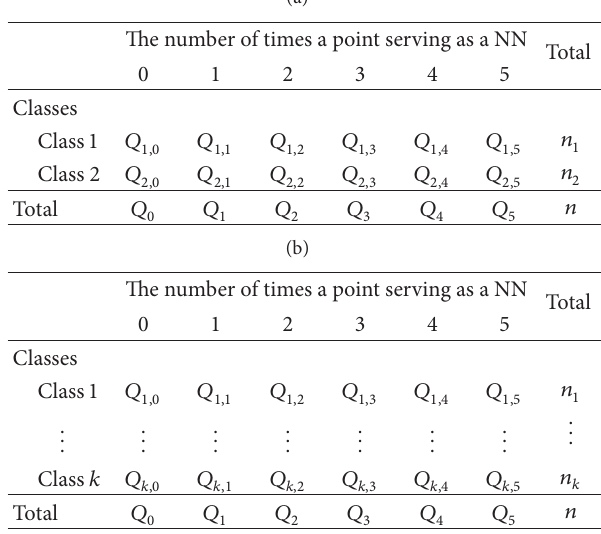
Table 2: The 𝑄 -symmetry contingency table for 𝑘 with 𝑘 = 2 (a) and 𝑘 > 2 (b).